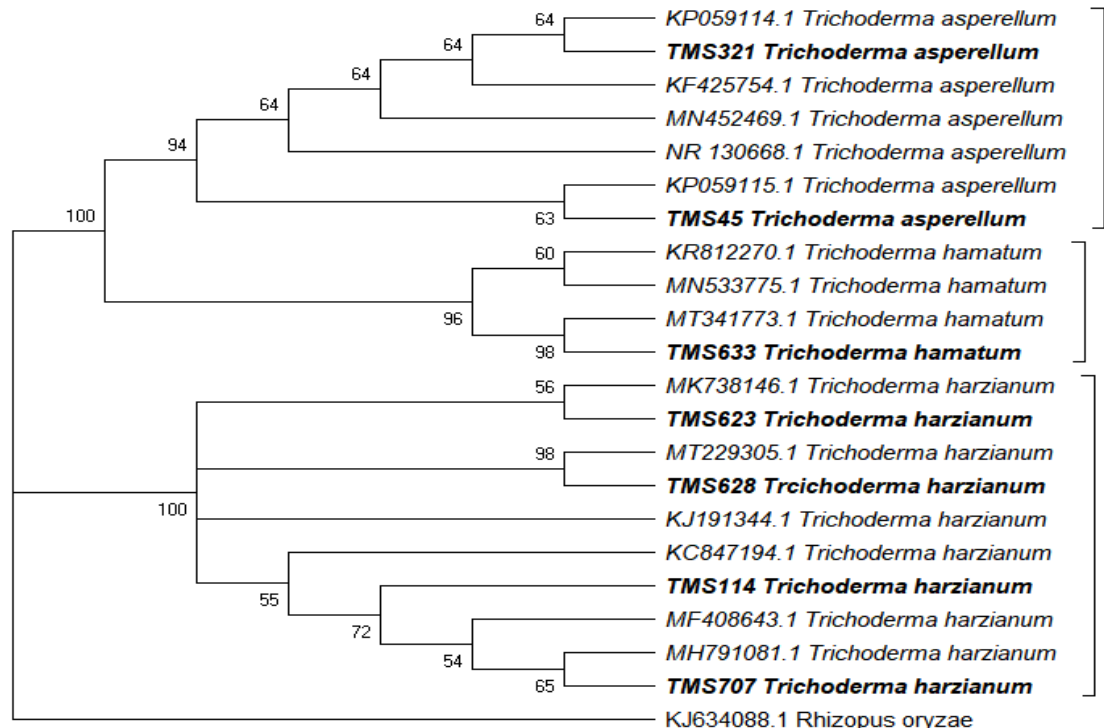
Figure 3. The phylogenetic relationship of the isolates according to the UPGMA method using gene sequences of ITS 1-5.8 S-ITS 2 regions of the rDNA. Bootstrap values that are shown by the nodes are based on 10,000 replicates. Bold lettering marked our isolates that were used in this study. Rhizopus oryzae (Mucorales: Mucoraceae) acts as the outgroup of this analysis. After 24 h of treatment, 13.33% mortality was found by T. harzianum (TMS623) in 1 × 10 8 conidia mL − 1 ( F = 45.20, p < 0.001) suspension. No nymph mortality was found in the controls up to 36 h of treatment (Figure